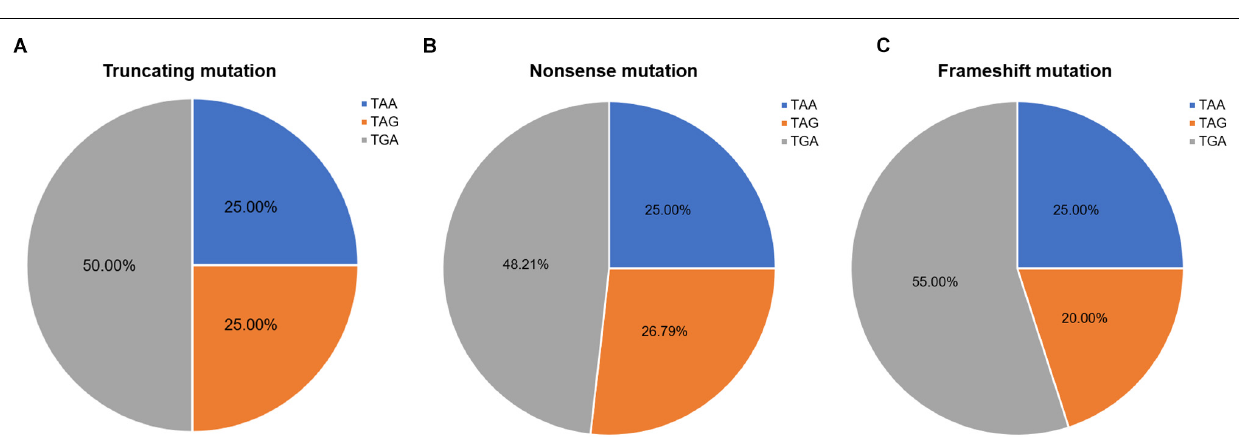
RD, while two small insertions were observed in each of the